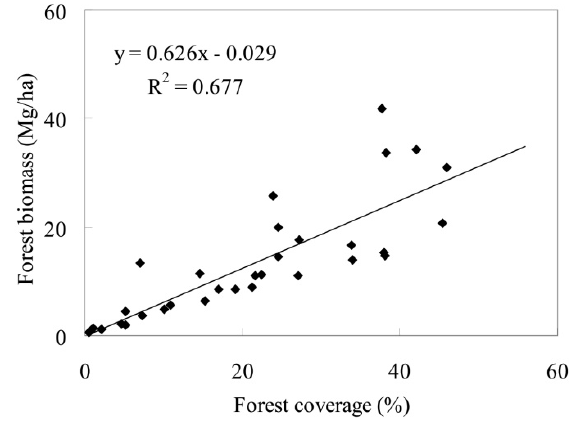
Figure 4. Relationship between forest coverage and biomass in China.